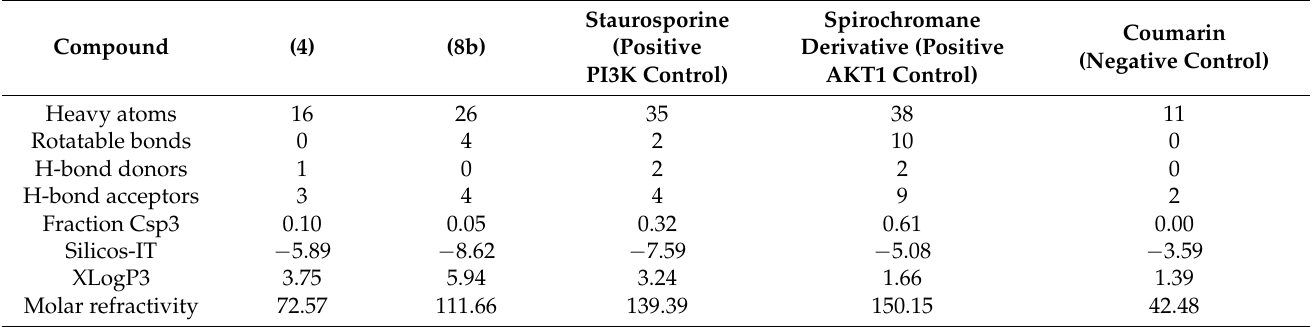
Table 2. Predicted physicochemical descriptors of the synthesized compound ( 4 ) and compound ( 8b ).